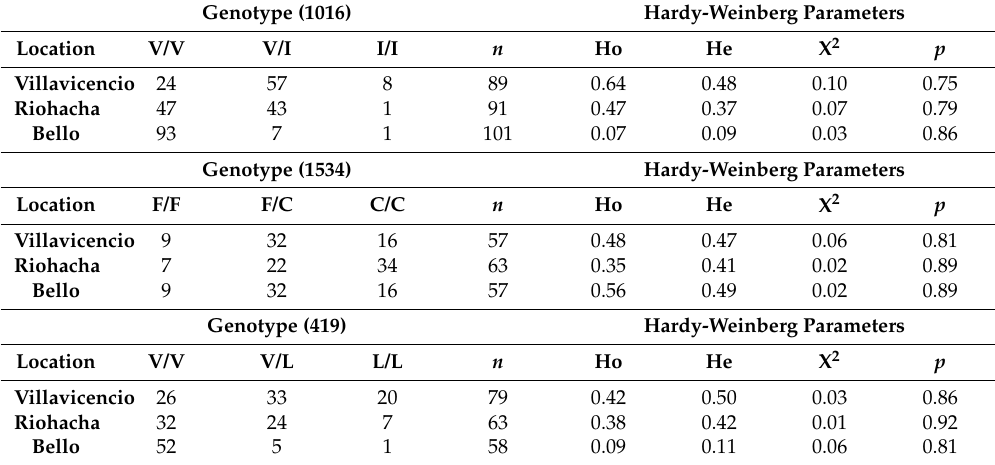
Table 3. Genotype frequencies and associated p values for Chi-Square tests for deviation from Hardy–Weinberg equilibrium of sodium channel mutations in Aedes aegypti from Colombia.